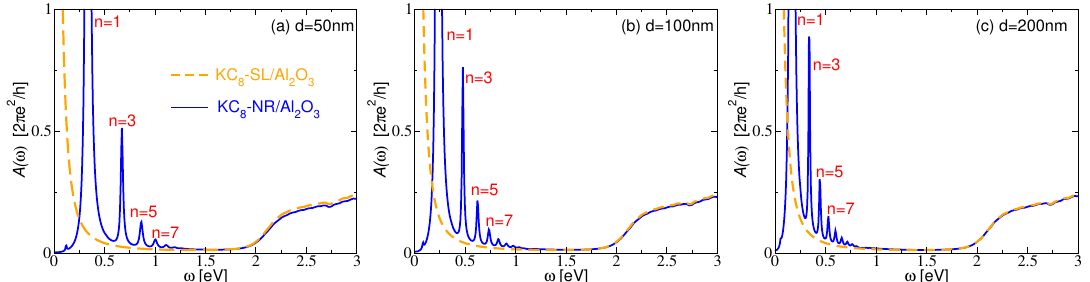
Figure 4. The absorption spectra of the KC 8 -NR of thicknesses ( a ) d = 50 nm, ( b ) d = 100 nm and ( c ) d = 200 nm (blue lines) and the absorption spectra of the KC 8 -SL (orange dashed lines). Both structures are deposited on a dielectric model Al 2 O 3 surface. The nanoribbon period is l = 2 d and z 0 = 3.0